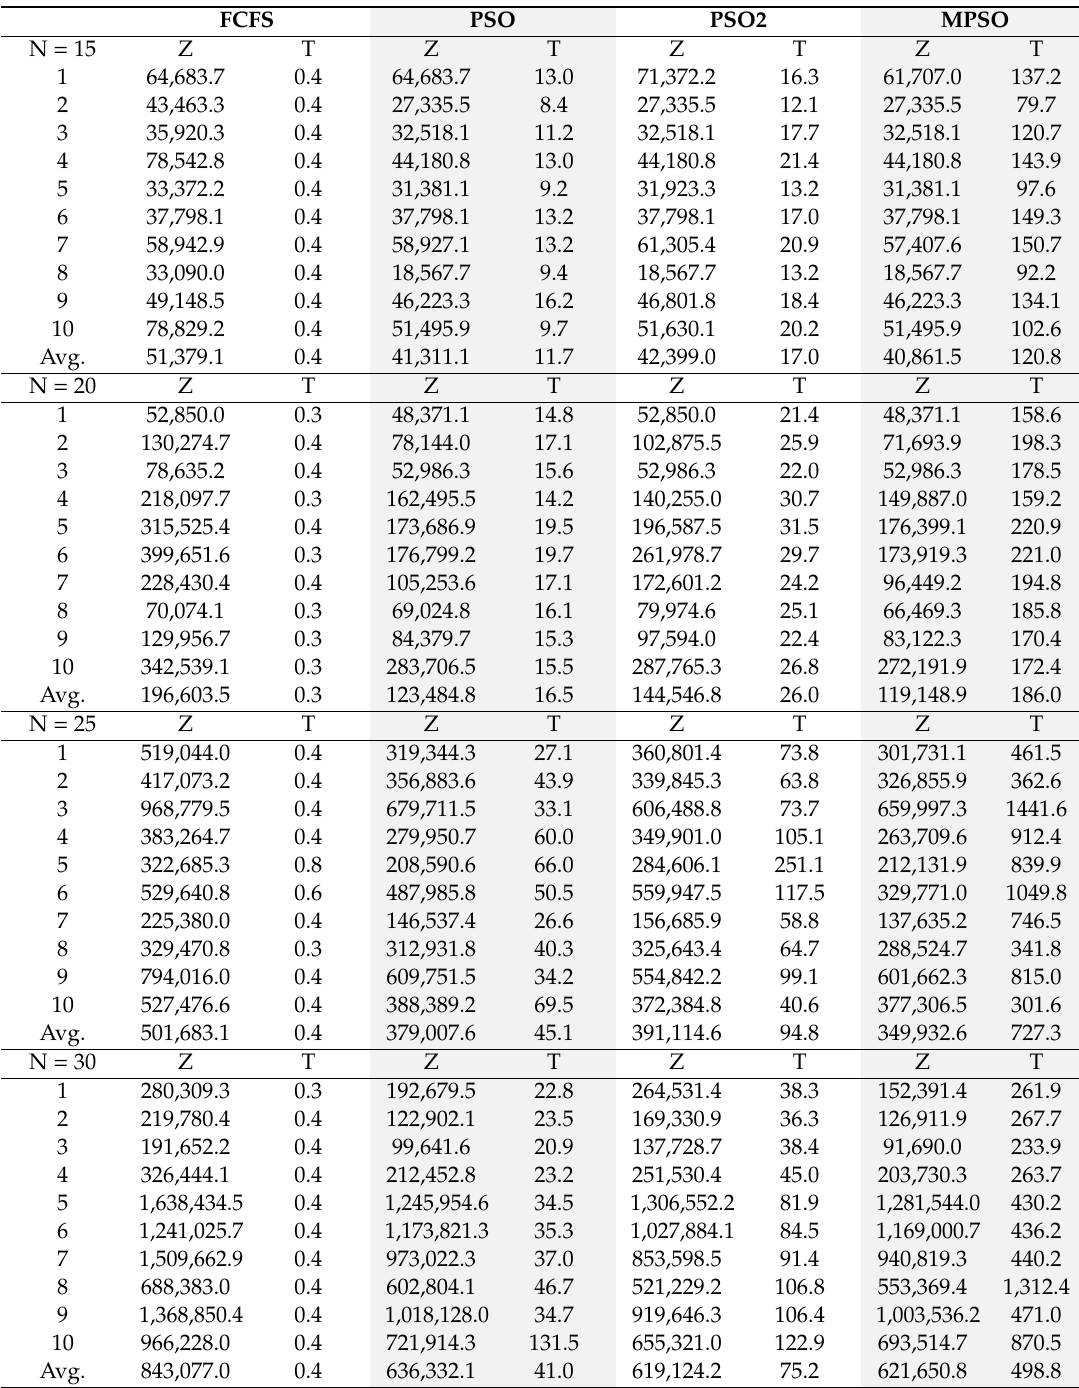
Table 6. The results obtained from di ff erent methods used in the first